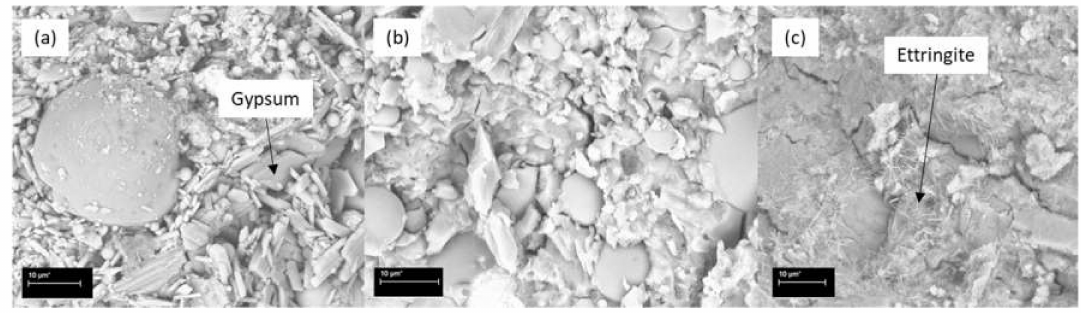
Figure 11. The concrete specimens in sulfuric acid, ( a ) M1S, ( b ) M3S, and ( c ) M5S.